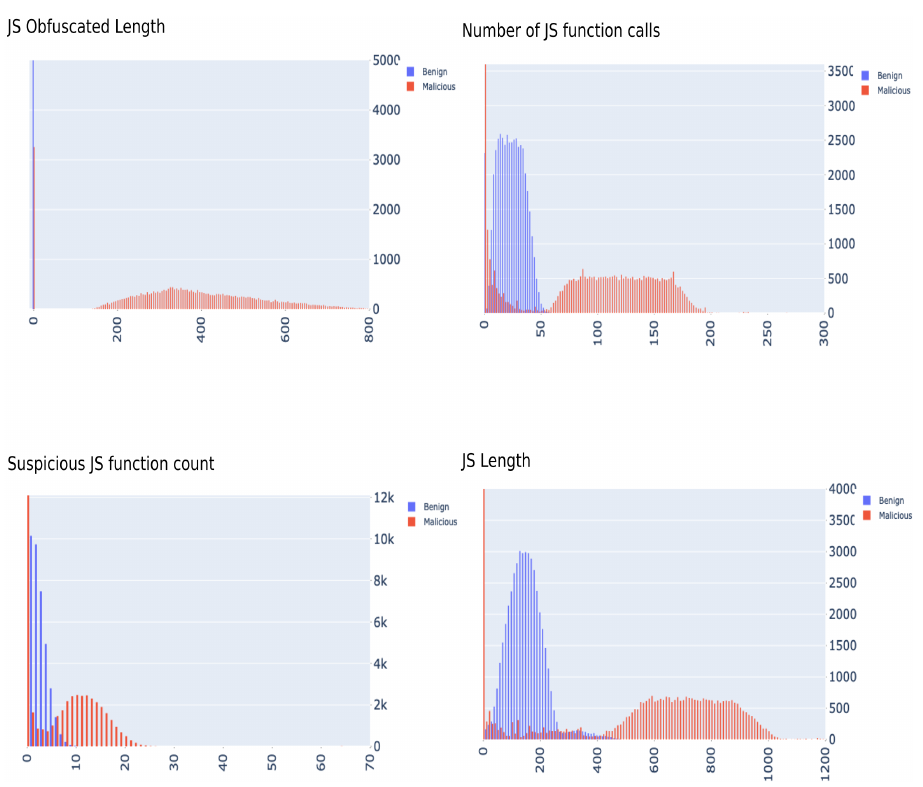
Figure 1. JavaScript features distributed by class for A.K. Singh